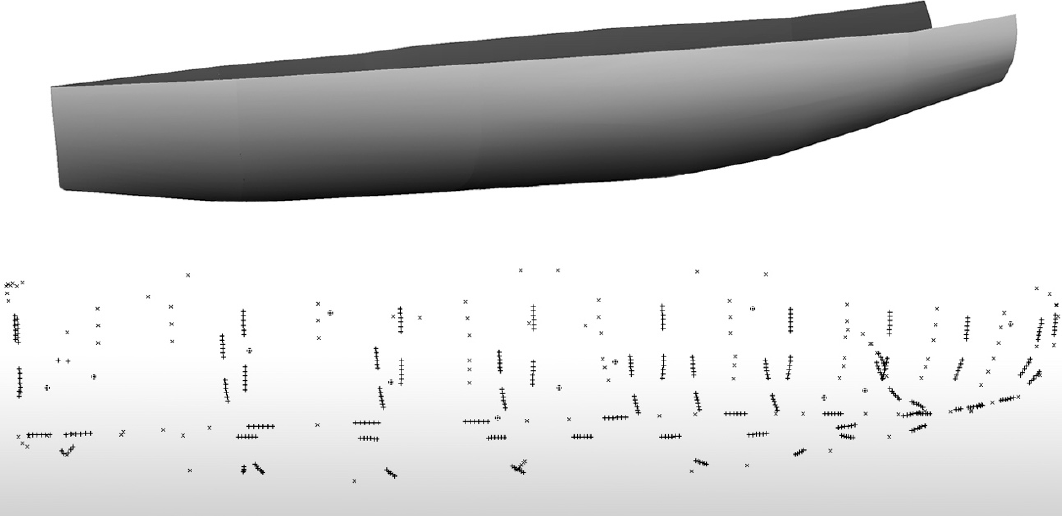
Figure 6. Scheme for imaging stations selected for the convergence case of digital Close Range Photogrammetry (CRP).